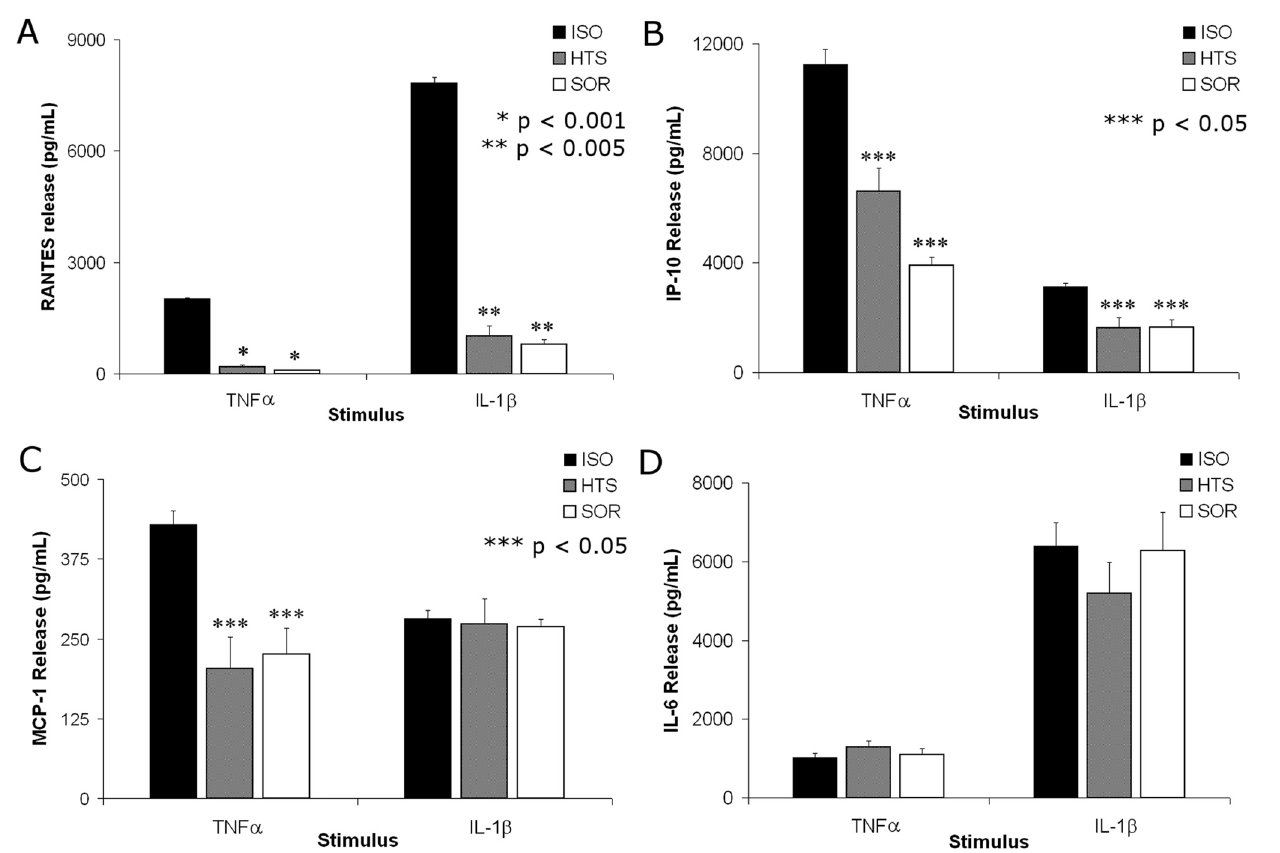
Figure 1. NaCl or sorbitol HOsmolarity (HOsm)inhibit chemokine secretion similarly, depending on stimulus. RANTES (A) and IP-10 (B) release was inhibited by both HTS and SOR when stimulated by TNF a or IL-1 b . HTS and SOR inhibited MCP-1 (C) release only when stimulated by TNF a but not by IL- 1 b . HOsm did not inhibit IL-6 (D) release with either stimulus. No significant differences were seen between HTS and SOR groups. Chemokine production was measured at 18 hours when treated with TNF a or IL-1 b in the presence of 400 mOsm HTS or